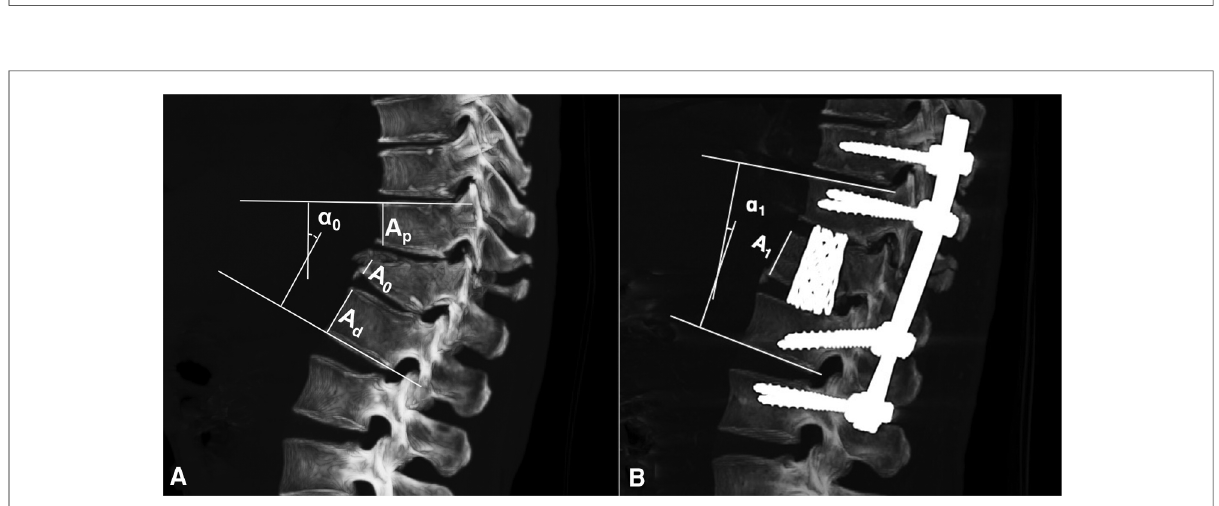
FIGURE 2 The measurement of angular deformity and anterior body height compression. A 0 was the anterior body height of injured level; A p and A d was the anterior body height of the proximal and distal level; A 1 was the anterior body height of injured level after surgery; α 0 was pre-operative angle and α 1 was post-operative angle of